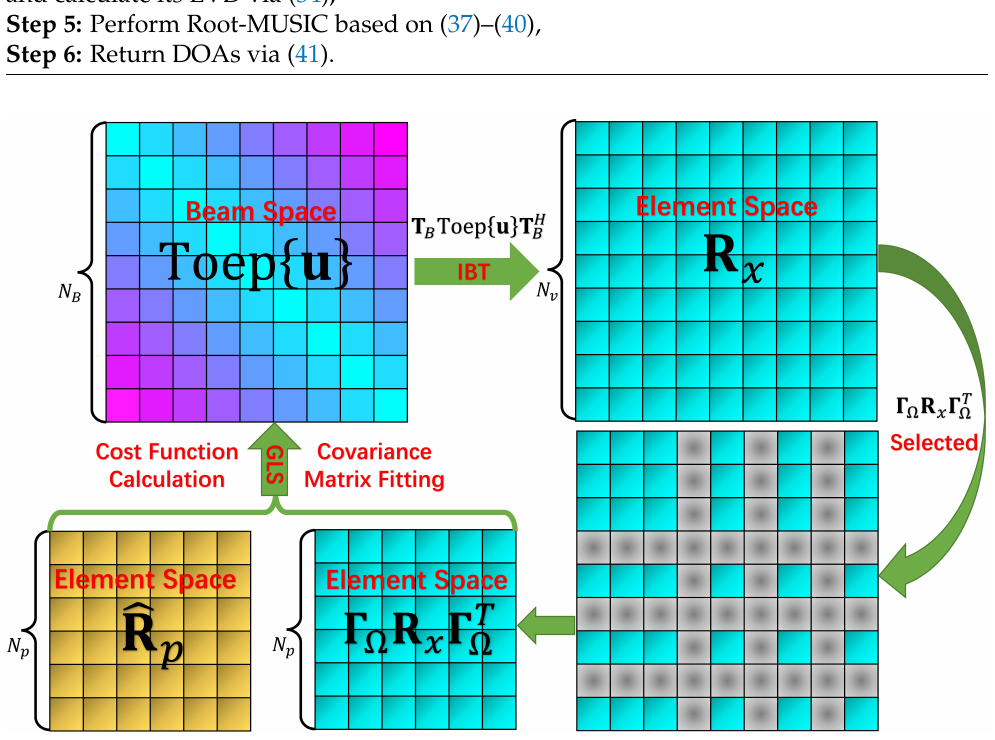
Figure 2. Schematic of Proposed GSCA